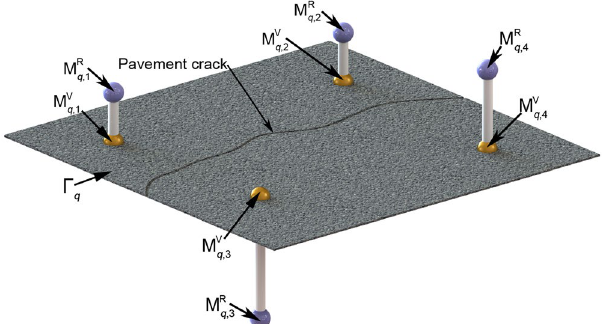
Figure 3. The active solution model of the homography in the camera coordinate system. The laser lines are projected on the pavement. The laser points are derived from the intersections between the laser lines and the pavement plane. All the pavement intersection points are represented in the global coordinate